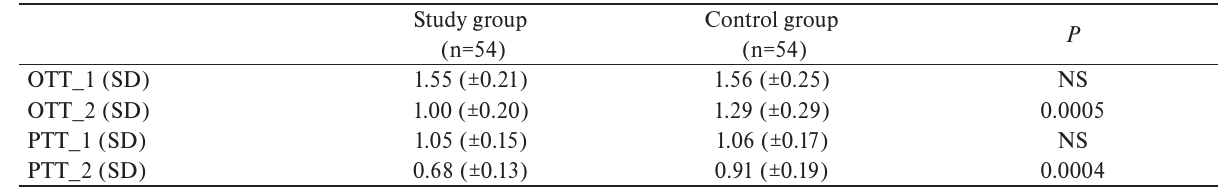
Table 2. VFSS – transit times before and after therapy